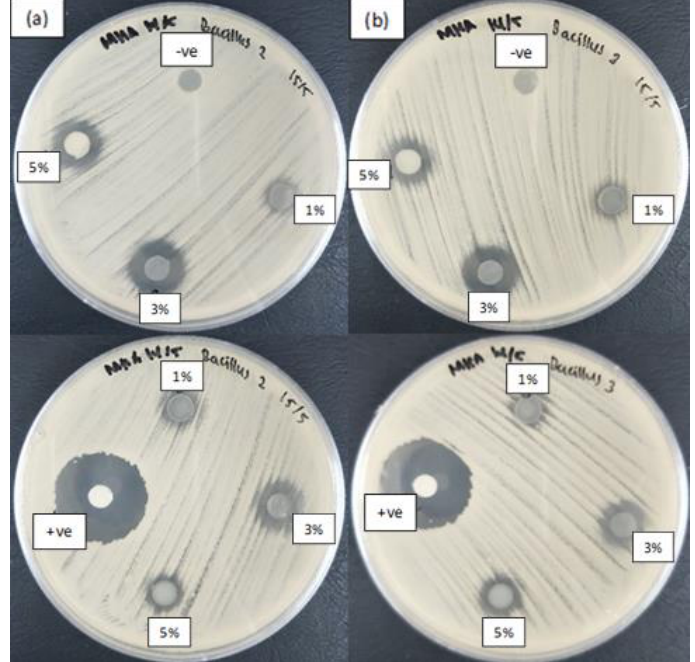
Figure 7. Zone of inhibition of starch films incorporated with different concentrations of synthesized ZnO NPs synthesized at column ( a ) with heating (60 °C) and column ( b ) without heating (28 °C) against Gram-positive Bacillus subtilis UPMC 1175. Film without ZnO NPs acted as negative control (“-ve”), while streptomycin antibiotic as positive control (“+ve”).